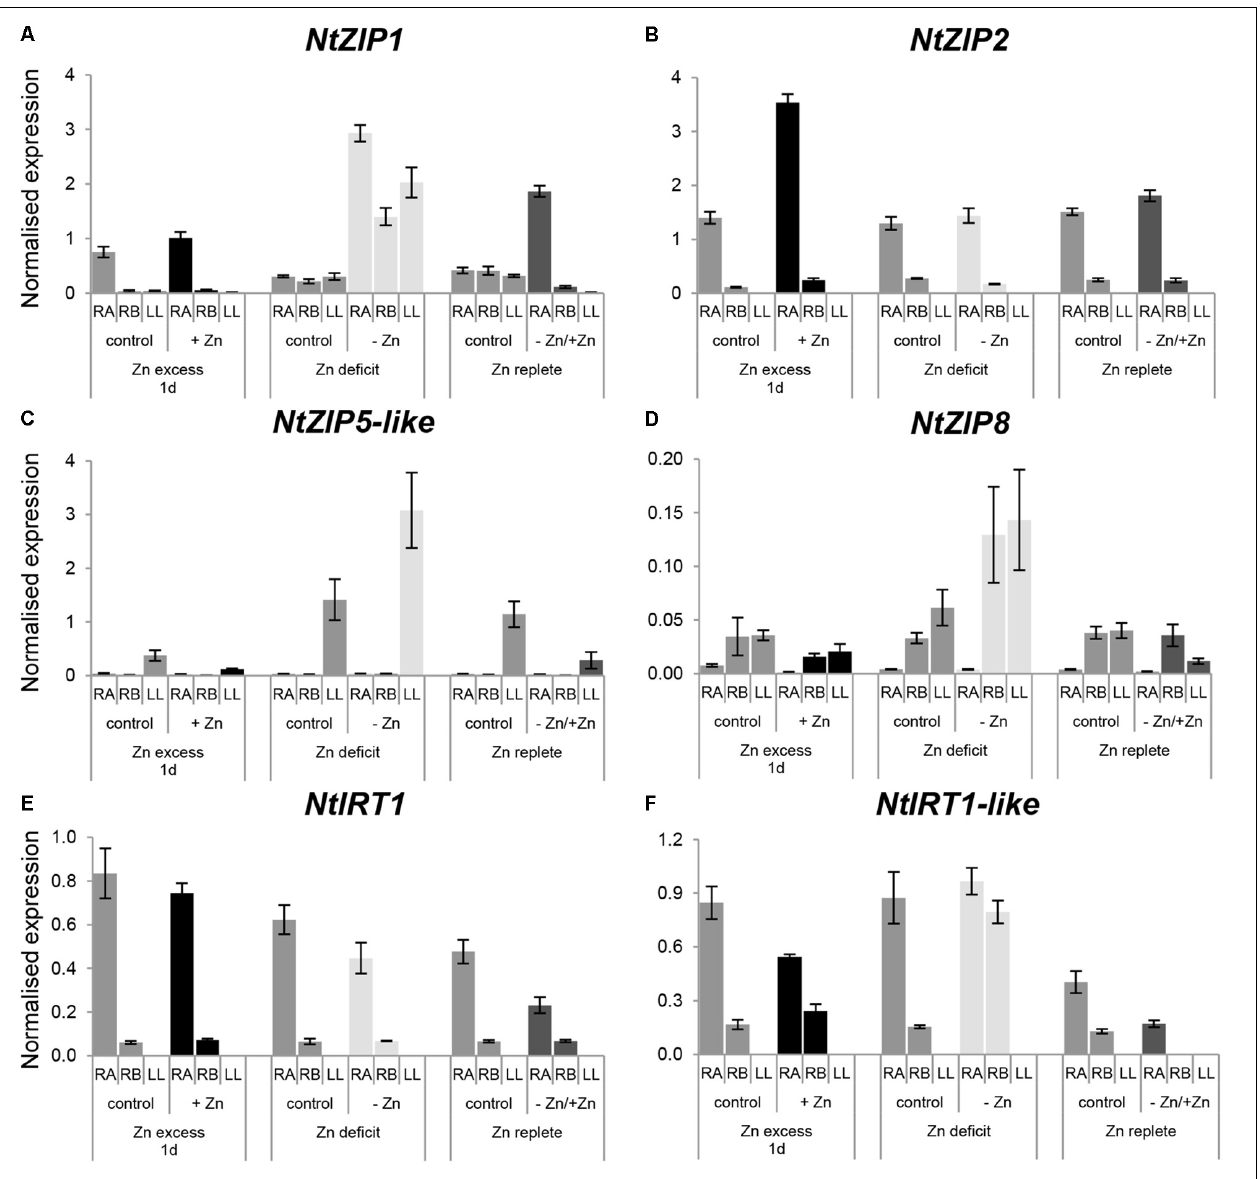
FIGURE 6 | Expression pattern of NtZIP1 (A) , NtZIP2 (B) , NtZIP5 (C) , NtZIP8 (D) , NtIRT1 (E) , and NtIRT1-like (F) in N. tabacum under various Zn conditions. Plants were grown in the quarter-strength Knop’s medium (control) and then transferred to the control medium supplemented with the following Zn concentrations: (i) 50 µ M Zn for 1 day (Zn excess-1d); (ii) without Zn for 4 days (Zn deficit); (iii) plants grown at Zn-deficiency for 4 days were transferred to the control medium for 2 days (Zn replete). RT-qPCR analyses was performed on cDNA prepared from the two old lower leaves counting from the base (LL), two young upper leaves (UL), apical part of roots (RA), and basal part of roots (RB) of N. tabacum . Gene expression was normalized to the PP2A level. Values correspond to means ± SD ( n = 3); those with the ratio greater than 2 are considered significantly